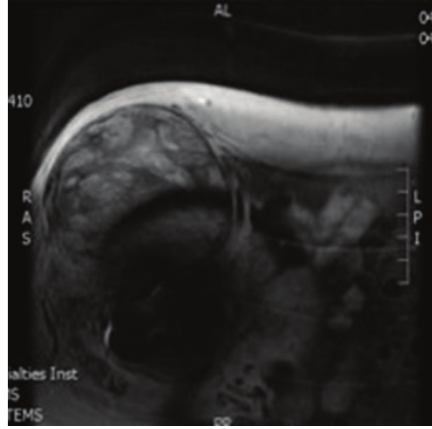
Figure 4: Pseudotumor status after